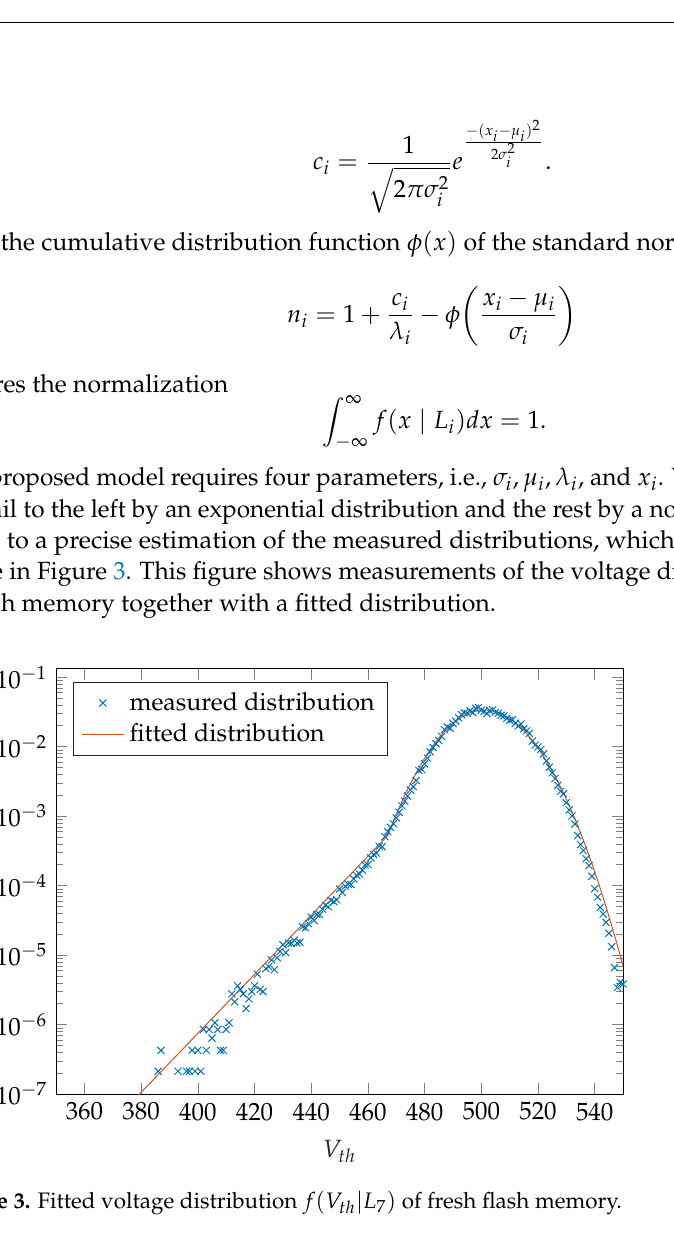
Figure 3. Fitted voltage distribution f ( V th